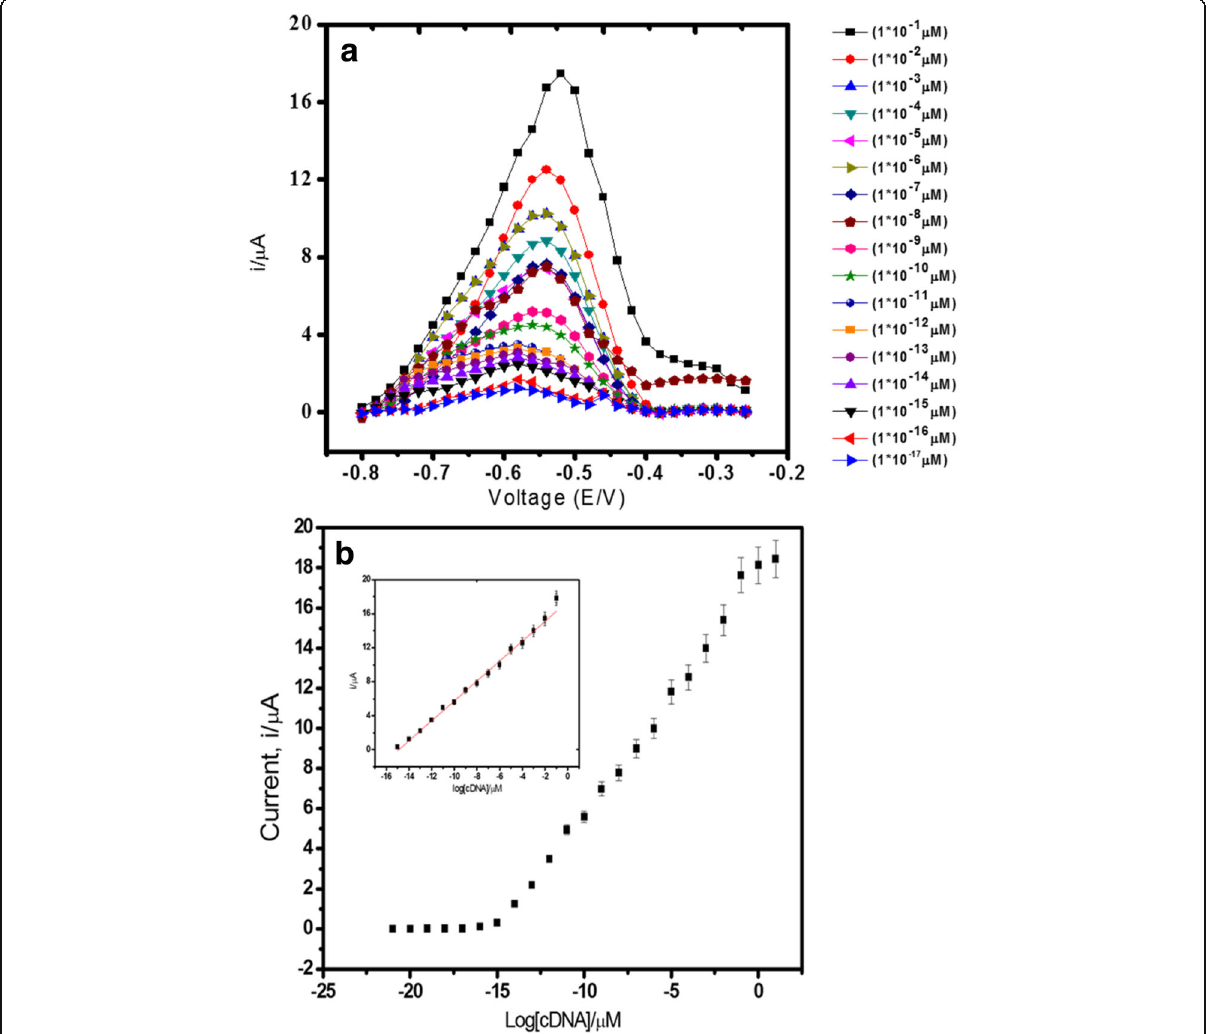
Fig. 6 Differential pulse voltammograms ( a ) and DNA biosensor linear range ( b ) obtained using various cDNA concentrations from 1.0 × 10 − 15 to 1.0 × 10 − 1 μ M V. cholerae target DNA and 5 μ M signal